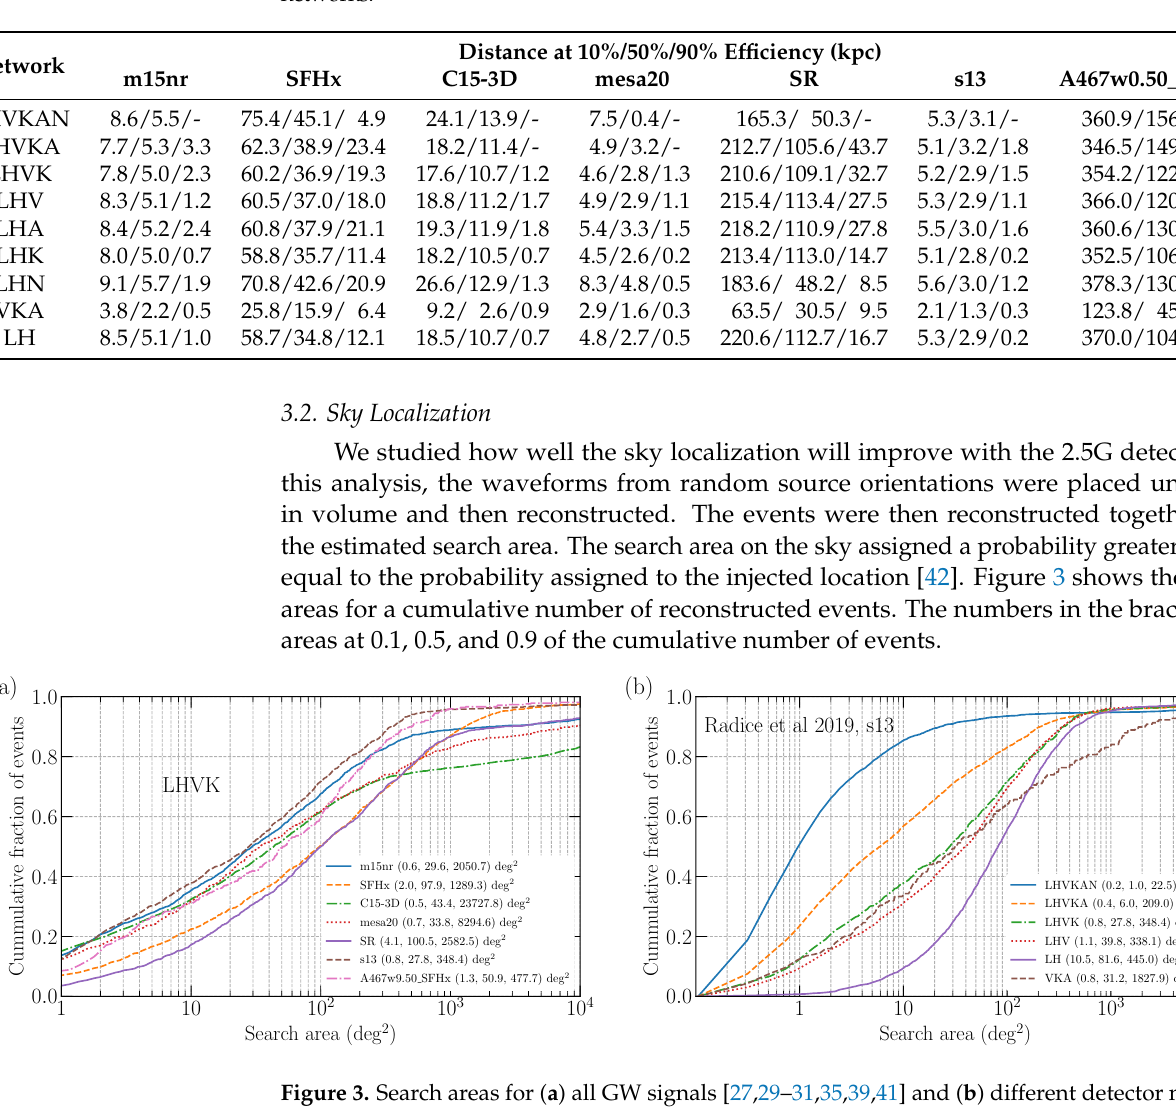
Table 1. Distances at 10%/50%/90% detection efficiency for all considered waveforms and detector networks.